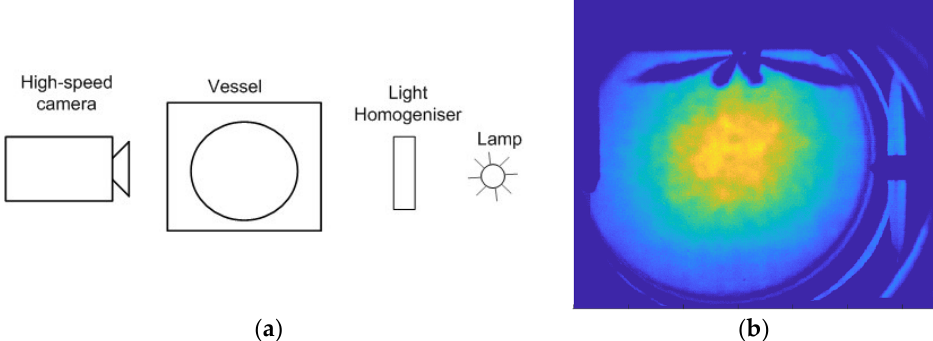
Figure 4. ( a ) Schematic of optical setup used in this work to back ‐ illuminate the Diesel spray; ( b ) typical photo of a Diesel spray in the vessel.